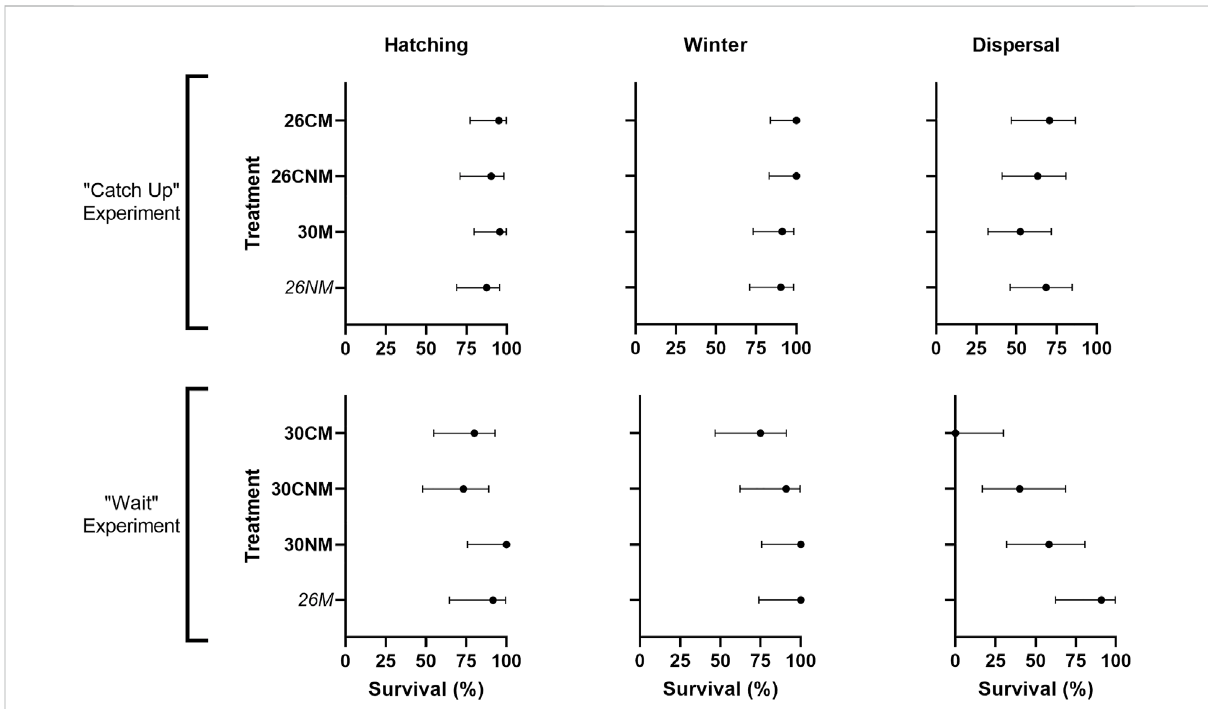
FIGURE 2 Hatching success and survival of early-hatching embryos versus their corresponding controls and/or sibs (top) early-hatching turtles from the catch-up experiment ( 26M ), their controls (26CM), and sibs (30NM) and (bottom) suspected early-hatching turtles from the wait treatment ( 26NM ) and their sibs (30M). Hatching success and post-hatching survival are reported as the proportion of individuals hatched or alive at the end of a given stage relative to the number in existence at the start of that stage, expressed as a percent. 95% con fi dence intervals are calculated using the Wilson/Brown method in Prism software (v9.4.0, GraphPad Software). The two treatments expected to suffer a cost are